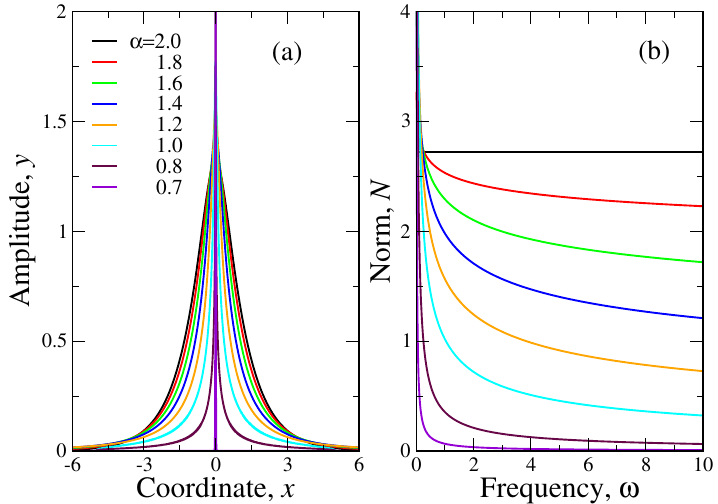
1 and 1 , corresponding χ = | | =